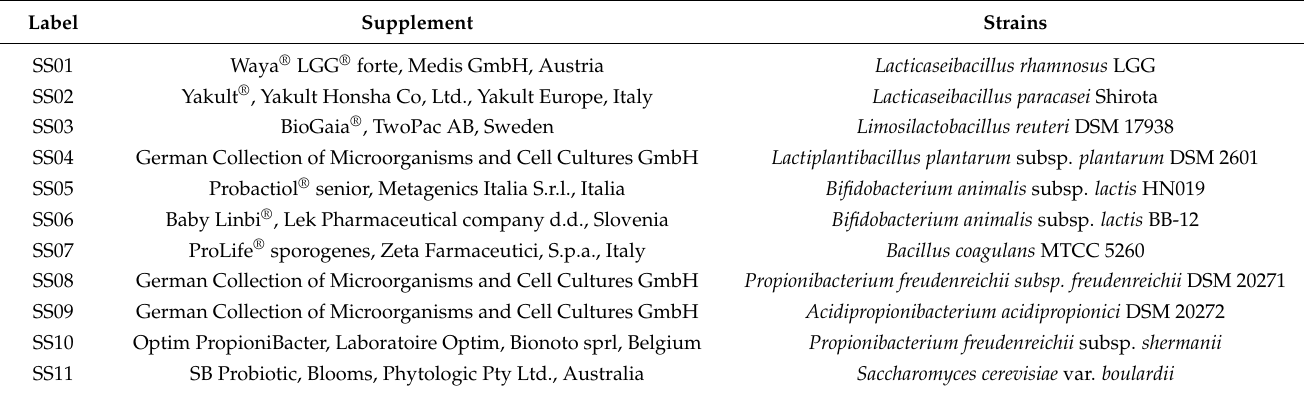
Table 2. Single-strain dietary supplements and other beneficial